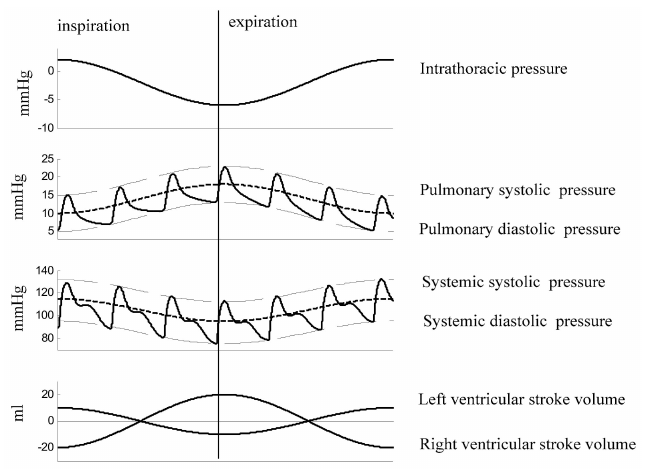
Figure 1. Diagrammatic sketch of the influence of respiration on pulmonary arterial pressure and systemic aortic pressure. (This figure is drawn by the authors. These curves are not based on clinical data of any human being or animal. They are only used to show qualitative relations).